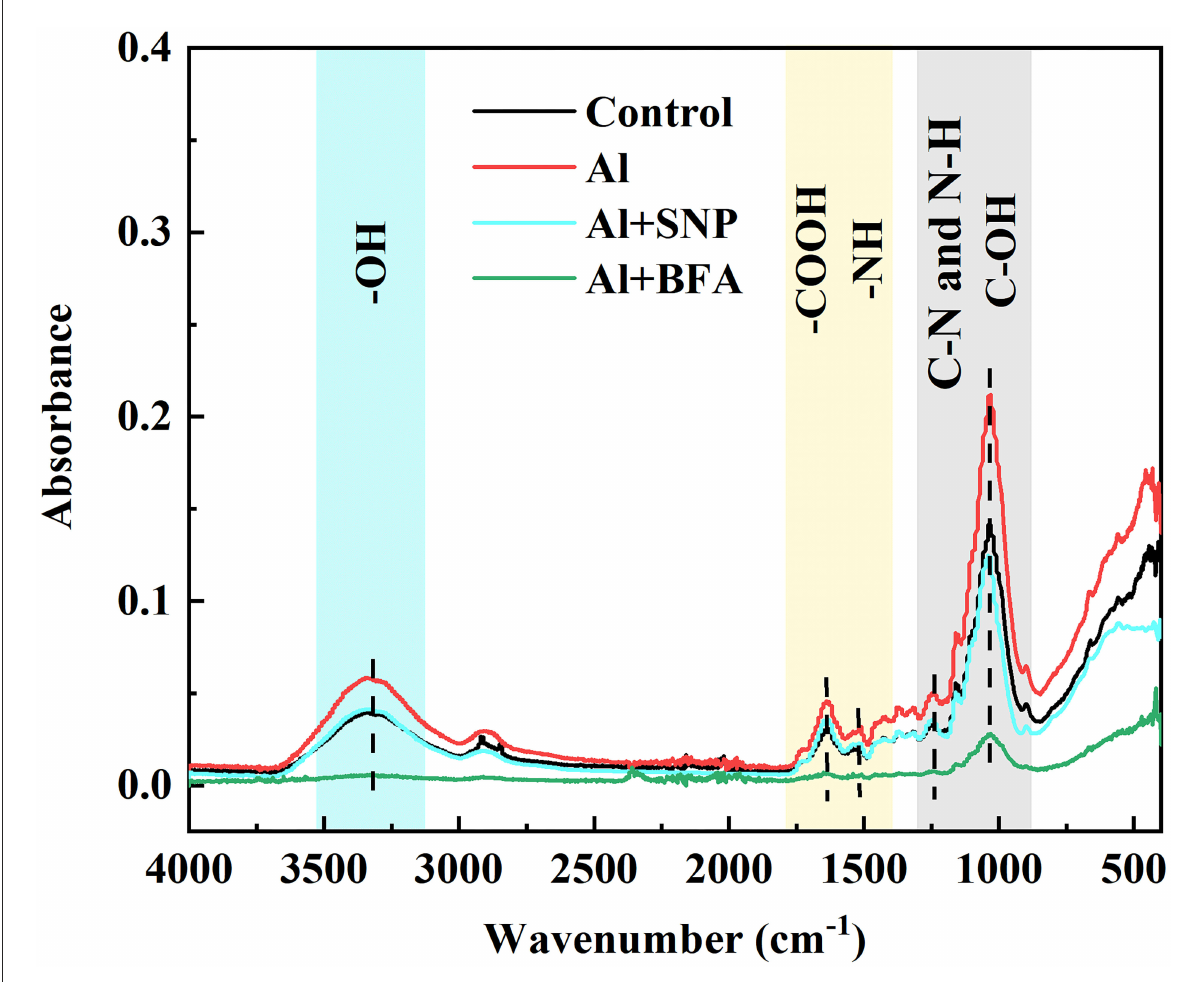
FIGURE6 The effect of BFA and SNP on FTIR spectra of cell wall in root tips under Al toxicity.